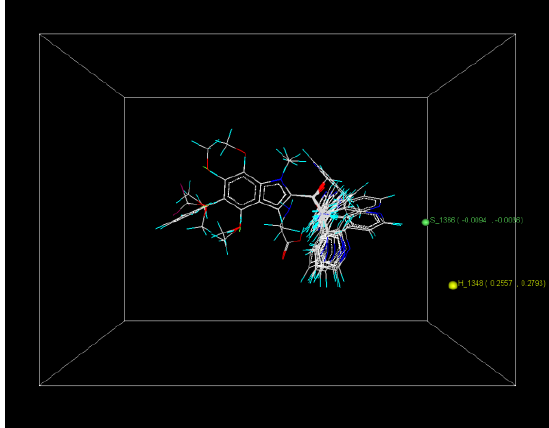
Figure 3 Stereoview of the molecular rectangular field grid around the superposed molecular units of Indol-2-yl ethanones series of compounds using SW- k NN MFA